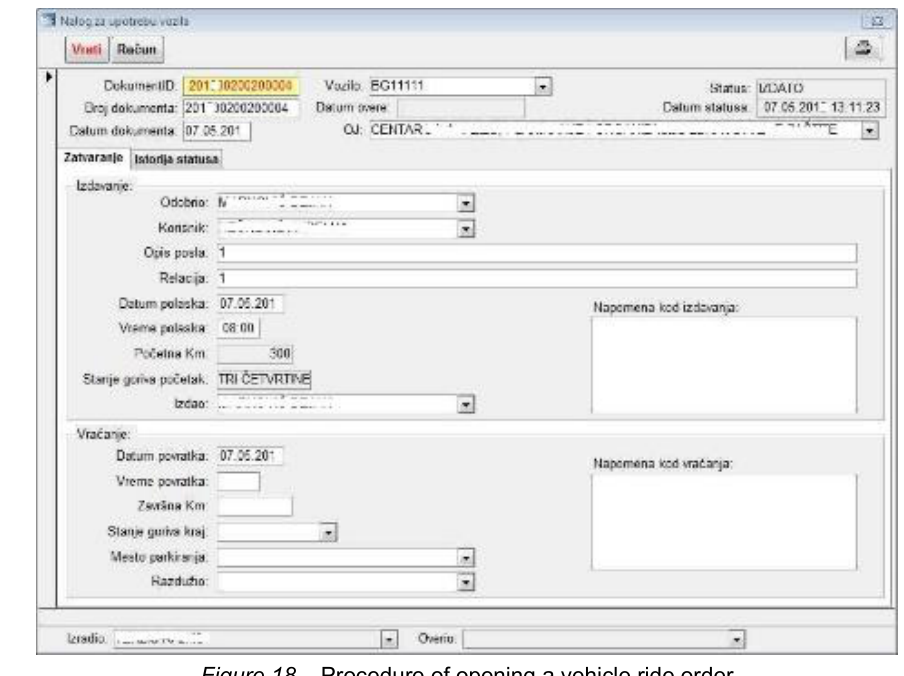
Figure 18 – Procedure of opening a vehicle ride order Рис . 18 – Порядок выписки путевого листана транспортное средство Slika 18 – Procedura otvaranja naloga za upotrebu